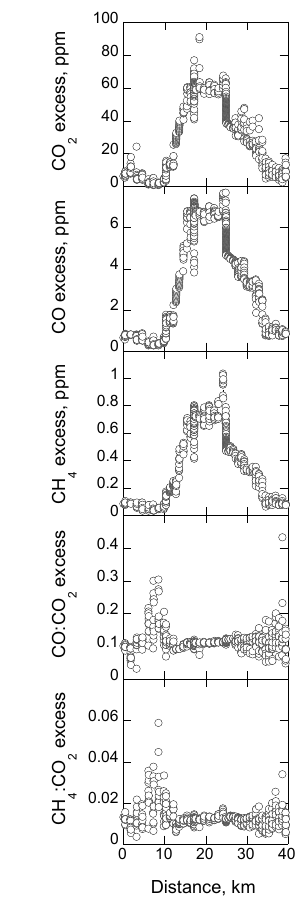
Figure 10. CO 2 , CO, and CH 4 mole fractions and the ratio of CO and CH 4 to CO 2 measured while driving along Forest Road 61, ad- jacent to the active fire line and inside the public restricted incident command area for the Trinity Ridge wildfire in Idaho, USA. Val- ues shown represent mole fraction above background mole fraction obtained from Wendover,